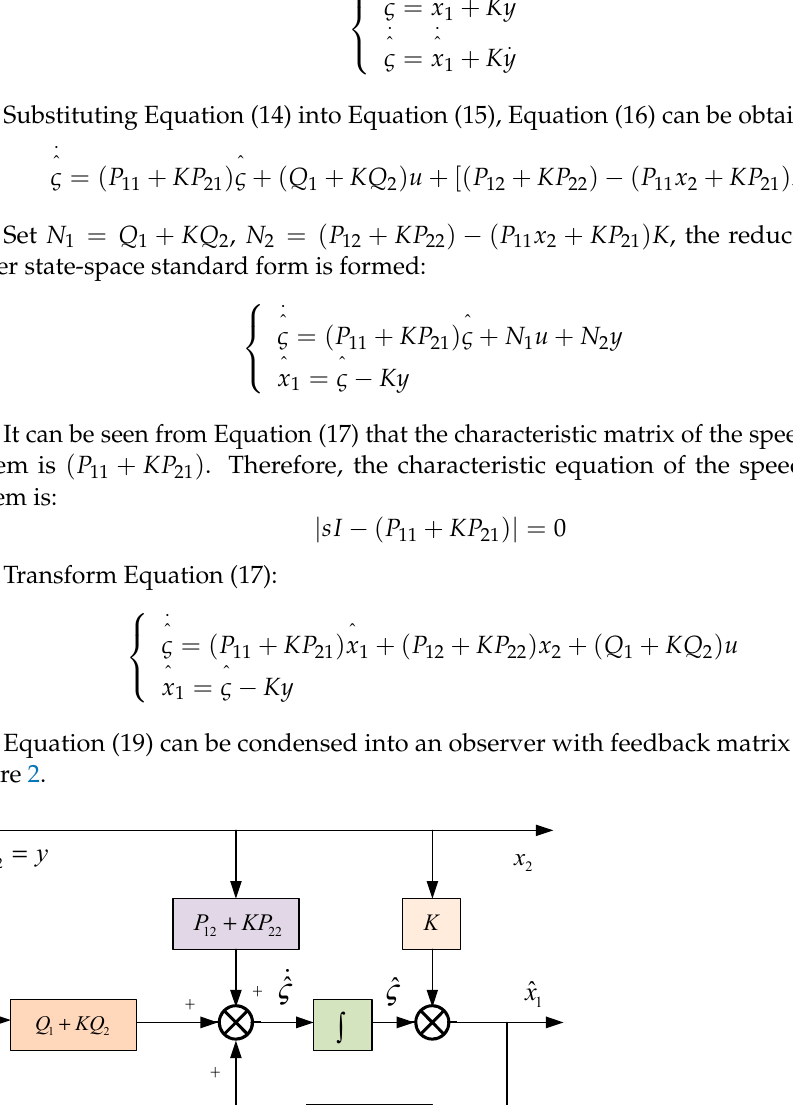
Figure 3. Pole distribution of motor under rated speed after designed. The blue line is the pole distribution of the motor below the rated speed solved by the determinant equation det(